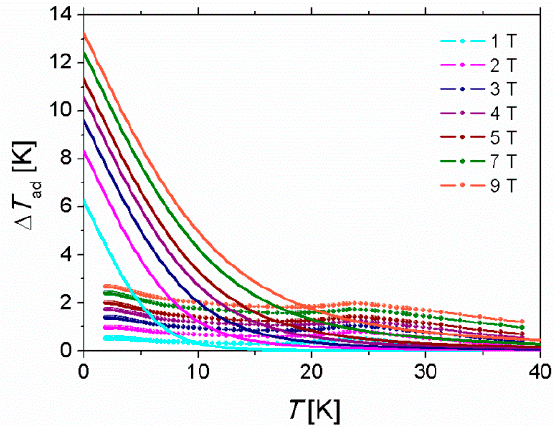
Figure 15. ∆ T ad of the hypothetical paramagnetic medium sharing with 2 the same spin content and the lattice heat capacity (solid lines). For the sake of comparison ∆ T ad of the studied compound has been also shown (symbols).